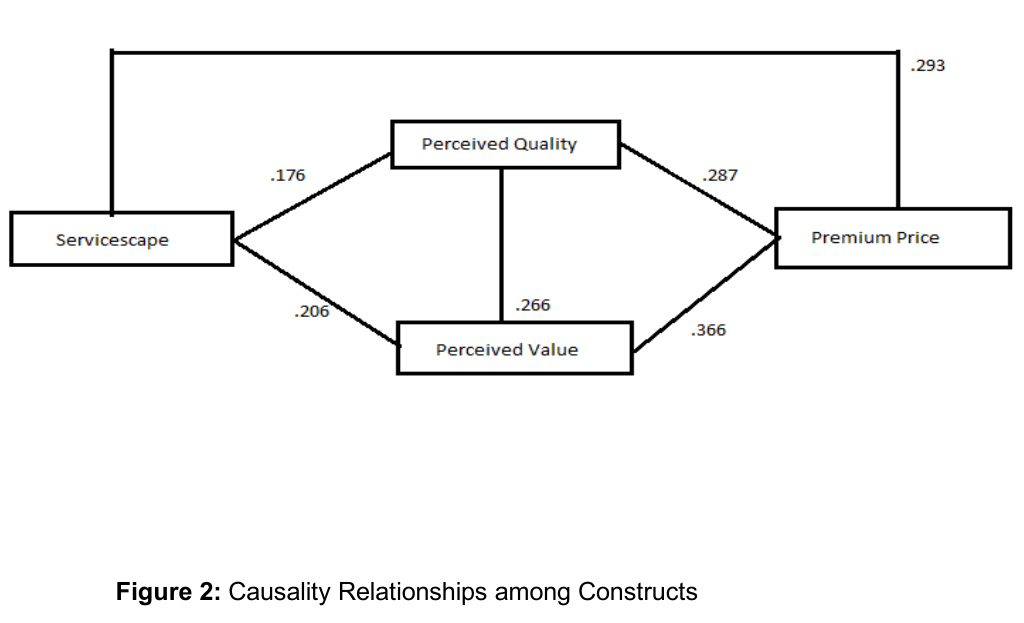
Figure 2: Causality Relationships among